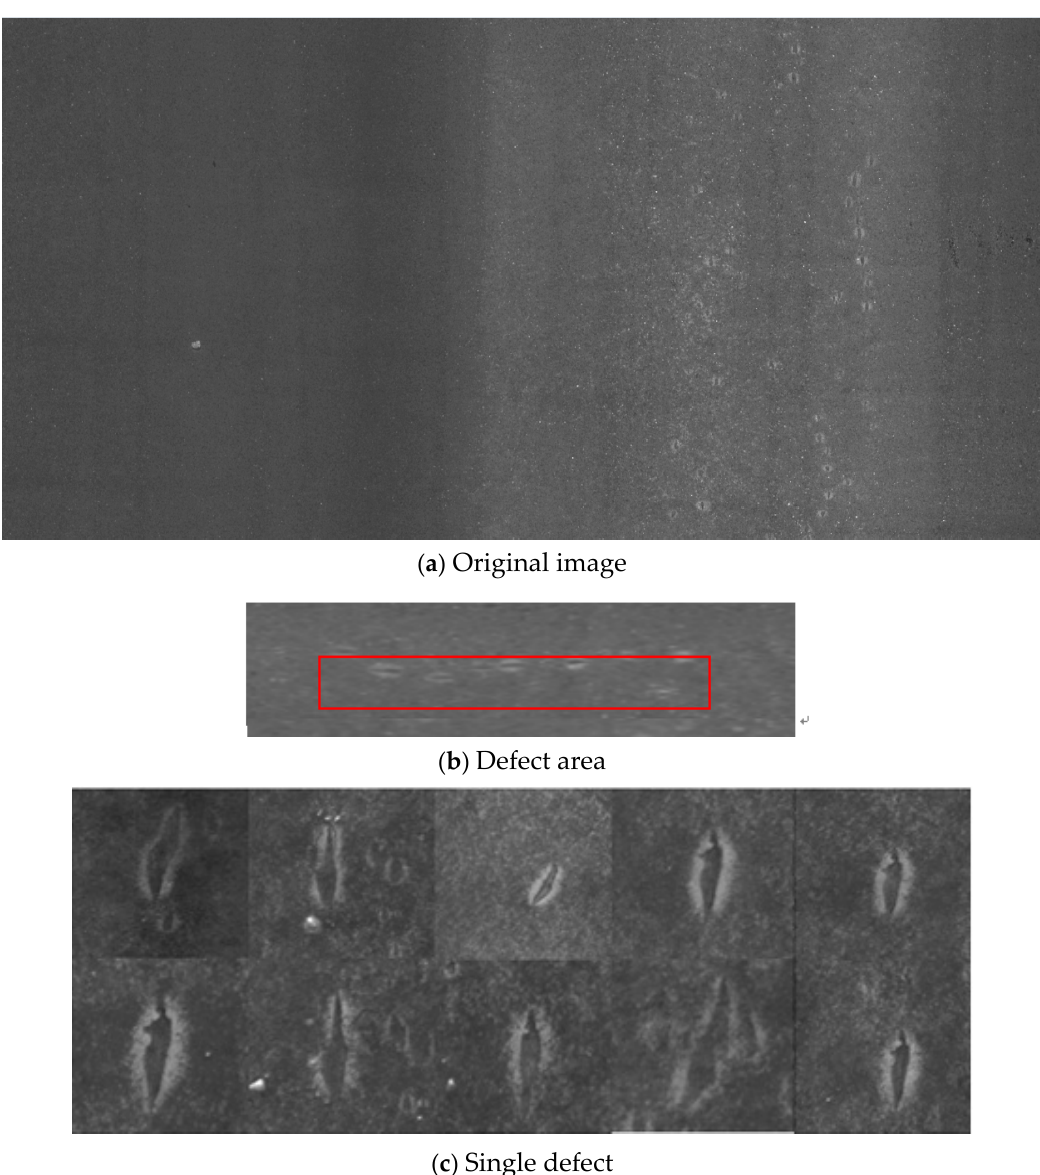
Figure 1. Images of rolling marks.